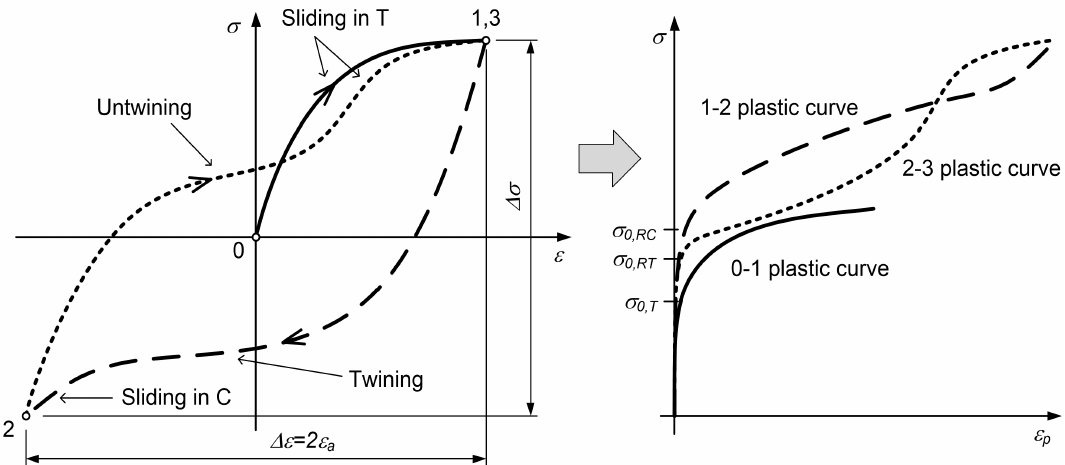
Figure 1. Initial tension loading and the closed hysteresis loop for the AZ31 magnesium